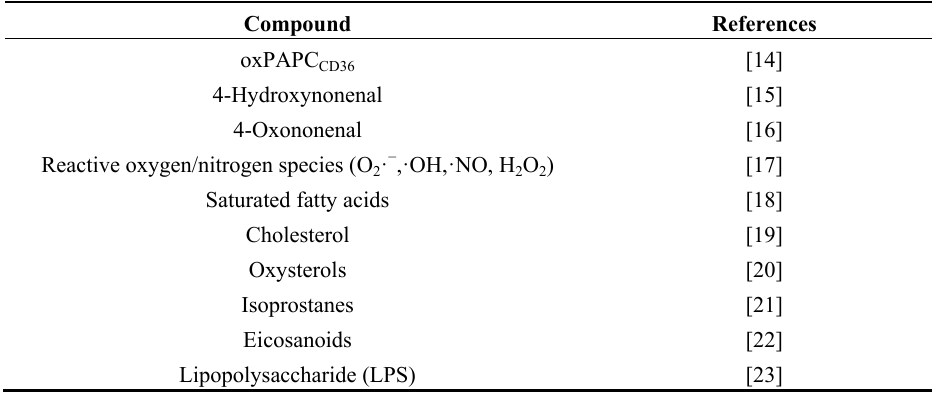
Table 2. Endogenous chemicals associated with